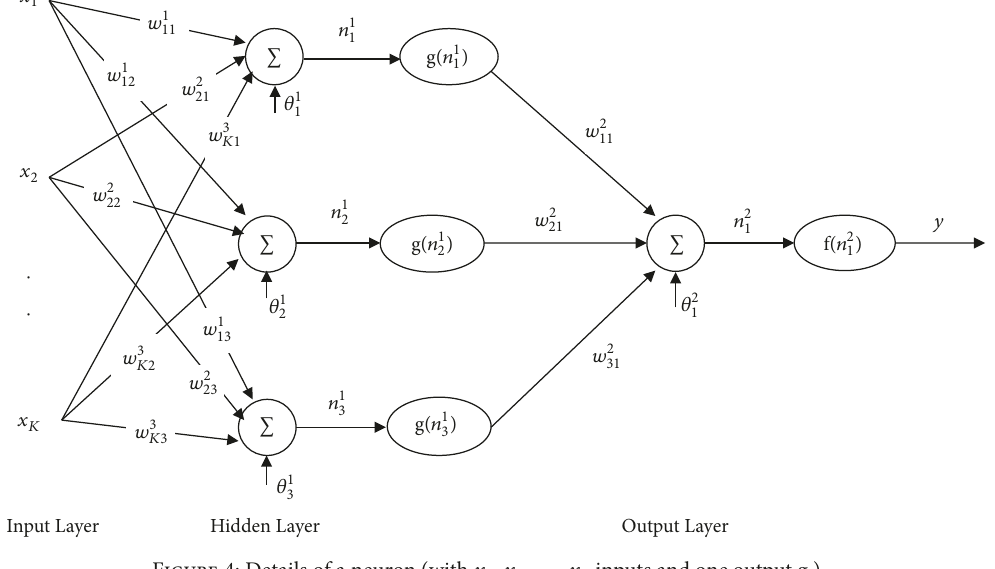
Figure 4: Details of a neuron (with 𝑥 1 , 𝑥 2 , .. ., 𝑥 𝑘 inputs and one output g j ).